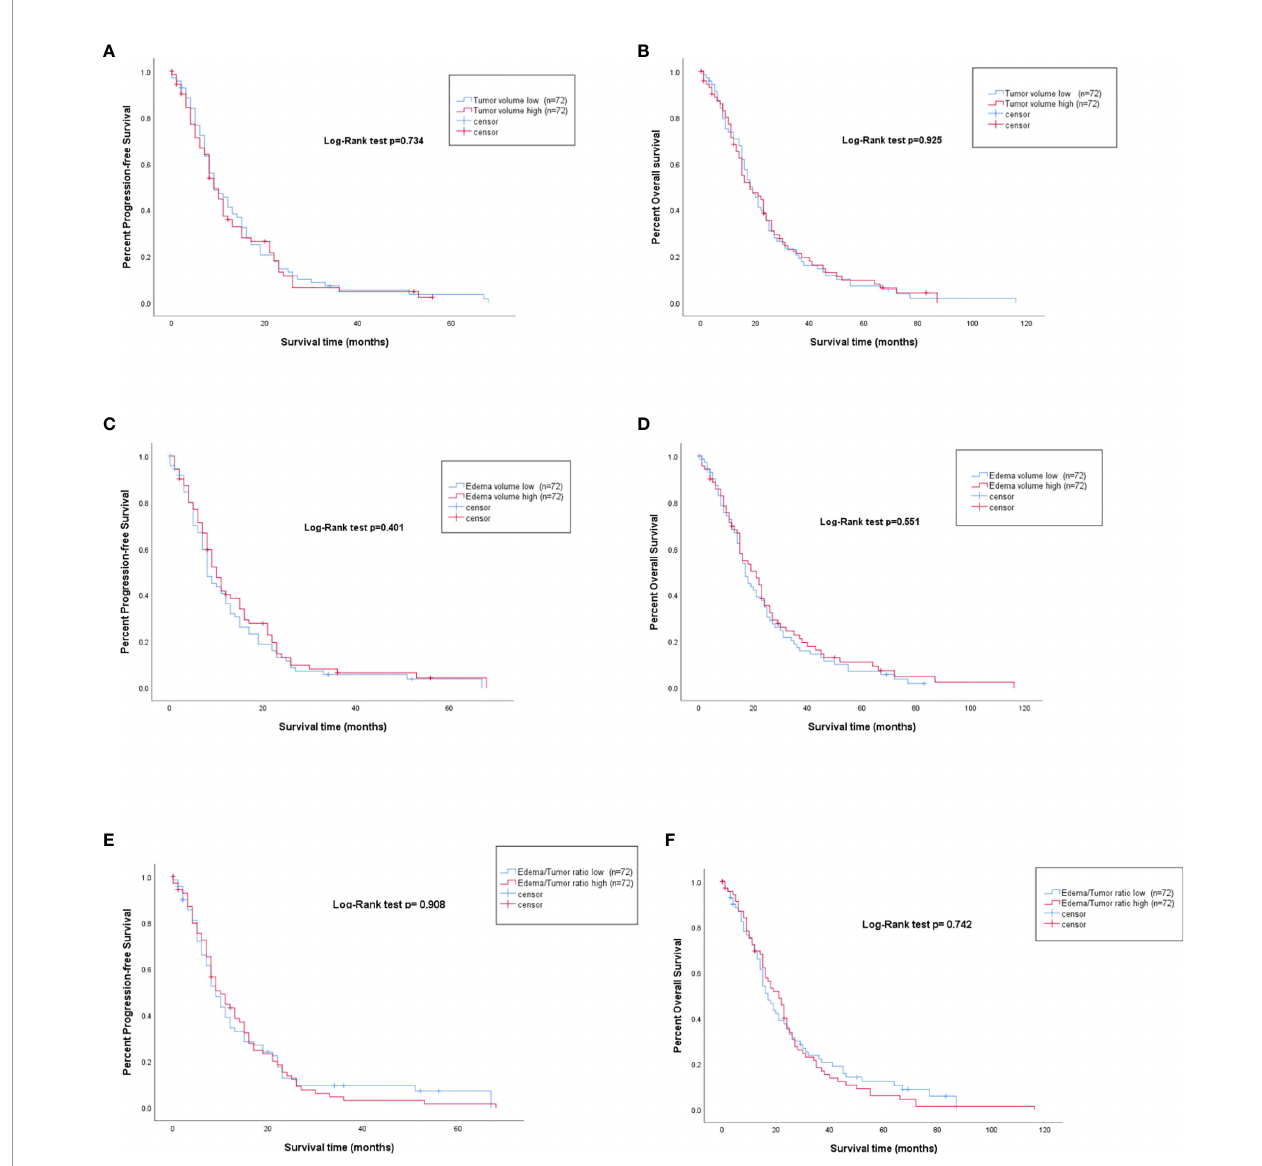
FIGURE 3 | PFS and OS represented by Kaplan-Meier curves for high vs. low preoperative tumor volume (A, B) , high vs. low preoperative edema volume (C, D) , and high vs. low edema to tumor ratio (E, F)